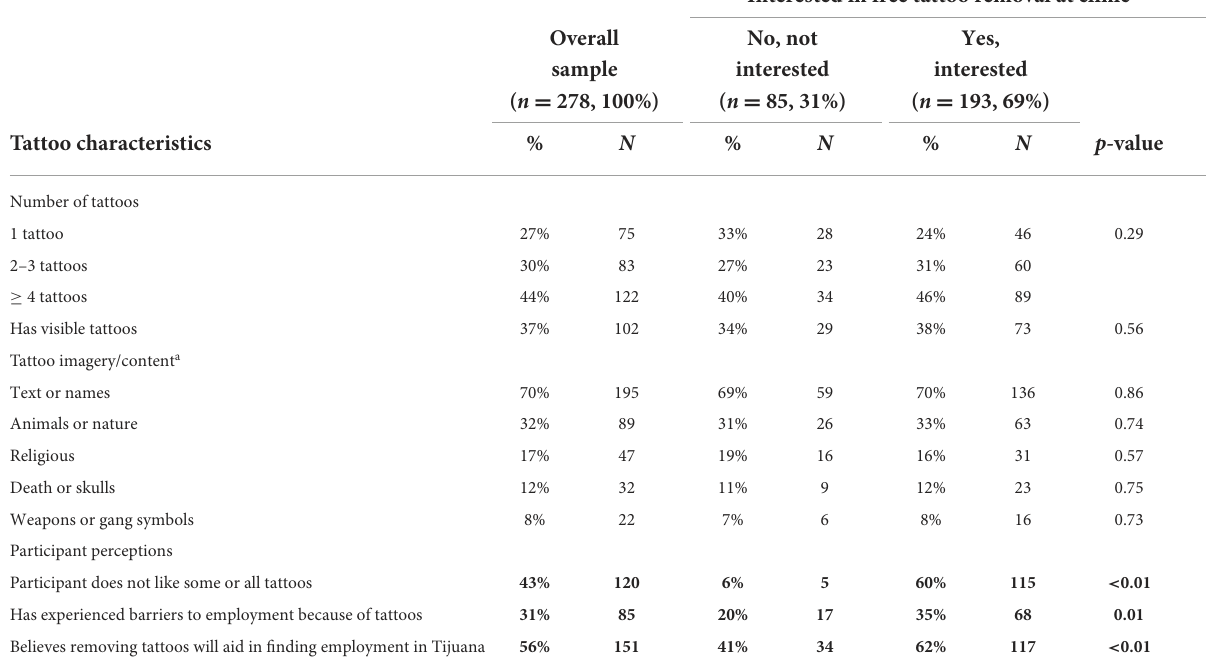
TABLE 2 Tattoo characteristics and participants’ perceptions, reported by Mexican tattooed adults ( n = 278) receiving free medical care, stratified by interest in receiving free laser tattoo removal at the study site, Tijuana, Mexico,